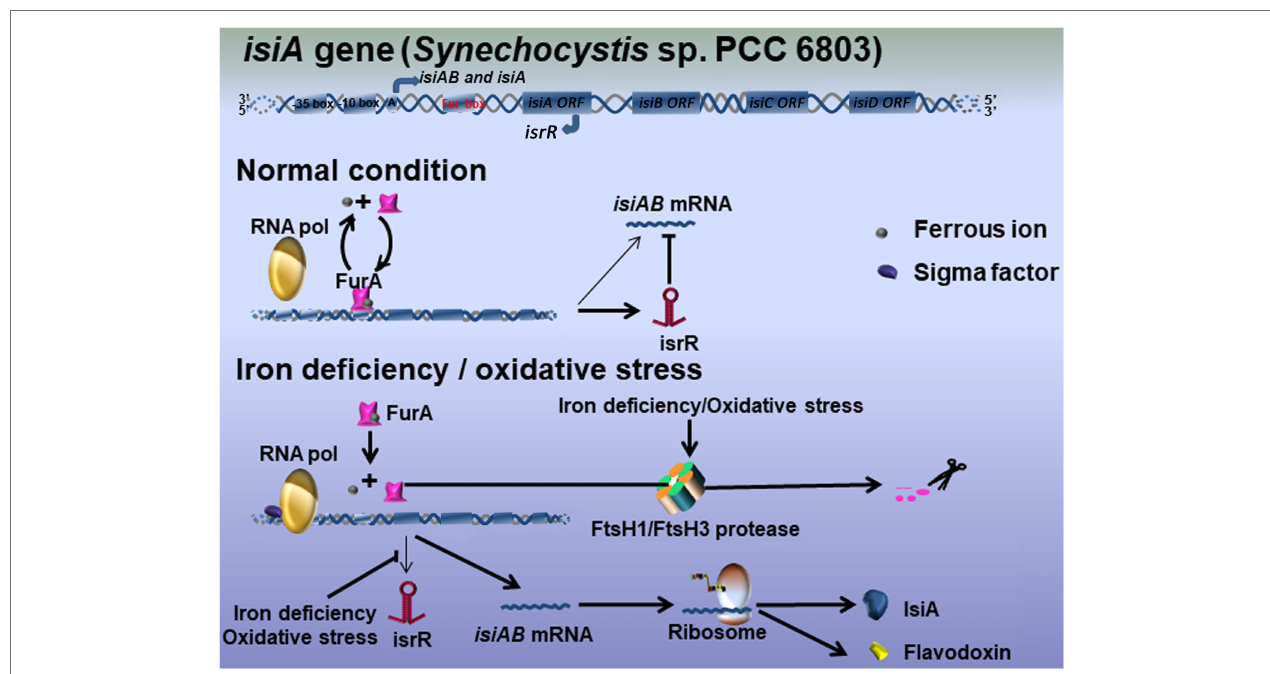
FIGURE 1 | Hypothetical model for the IsiA regulatory mechanisms in Synechocystis sp. PCC 6803. Three main transcripts originate in the operon isiAB : the bicistronic isiAB transcript, the isiA monocistronic transcript, and isrR microRNA. Under optimal growth conditions, iron-binding FurA represses the expression of IsiA at the transcriptional level. The equilibrium between iron-bound and unbound FurA is easily disturbed by variation in the environmental conditions, meaning isiA mRNA tends to be continuously expressed at very low levels. The antisense RNA isrR mediates the degradation of isiA mRNA at the post-transcriptional level. Under iron-limited or oxidative stress conditions, FurA is downregulated by either stress-induced antisense RNA or the FtsH1/FtsH3 protease, leaving RNA polymerase to interact with an unknown activator to initiate isiA transcription. isrR is also repressed, leading to the further accumulation of isiA mRNA and the biosynthesis of